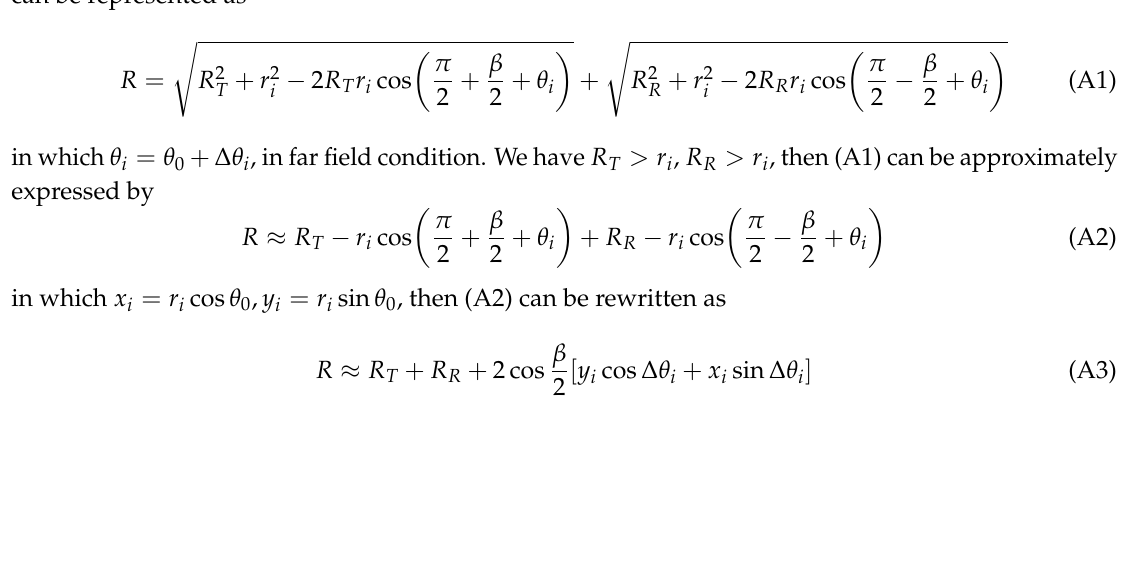
Figure 10. Curves of imaging performance under different measurements. ( a ) Entropy versus measurements, ( b ) RMSE versus measurements, and ( c ) CC versus measurements.